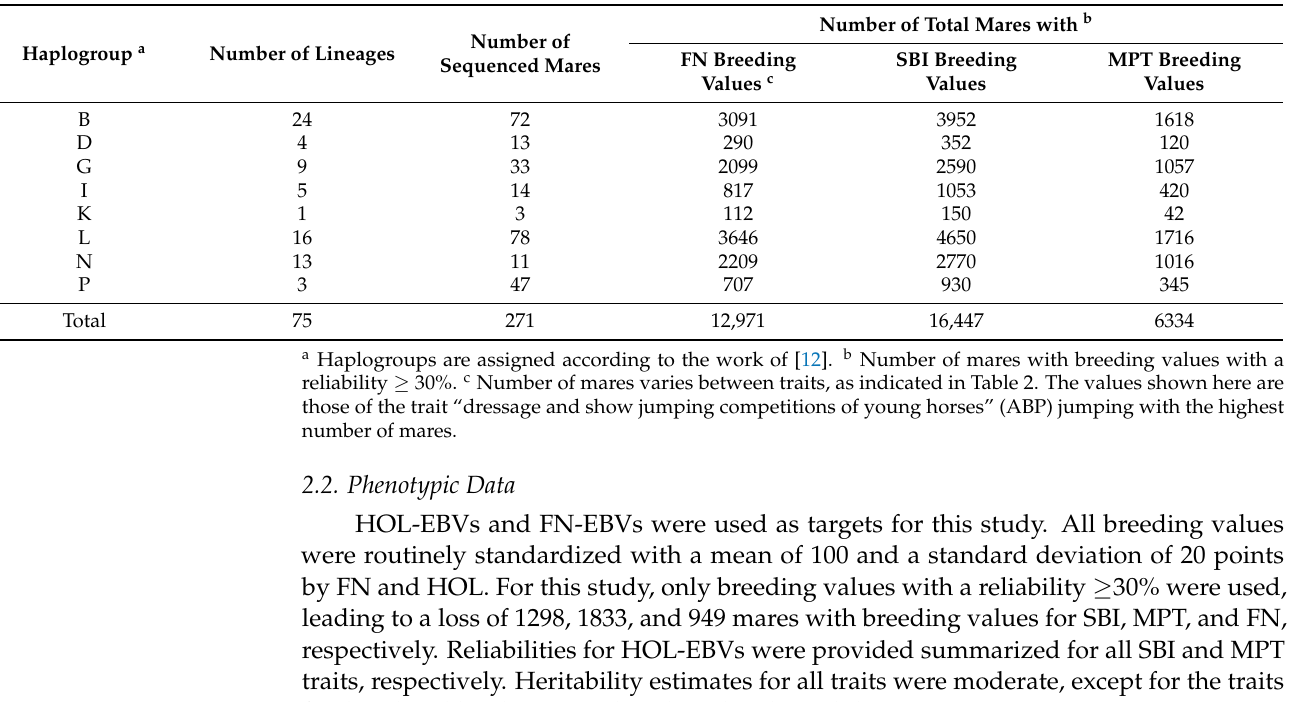
Table 1. Overview of the data set and distribution of lineages among